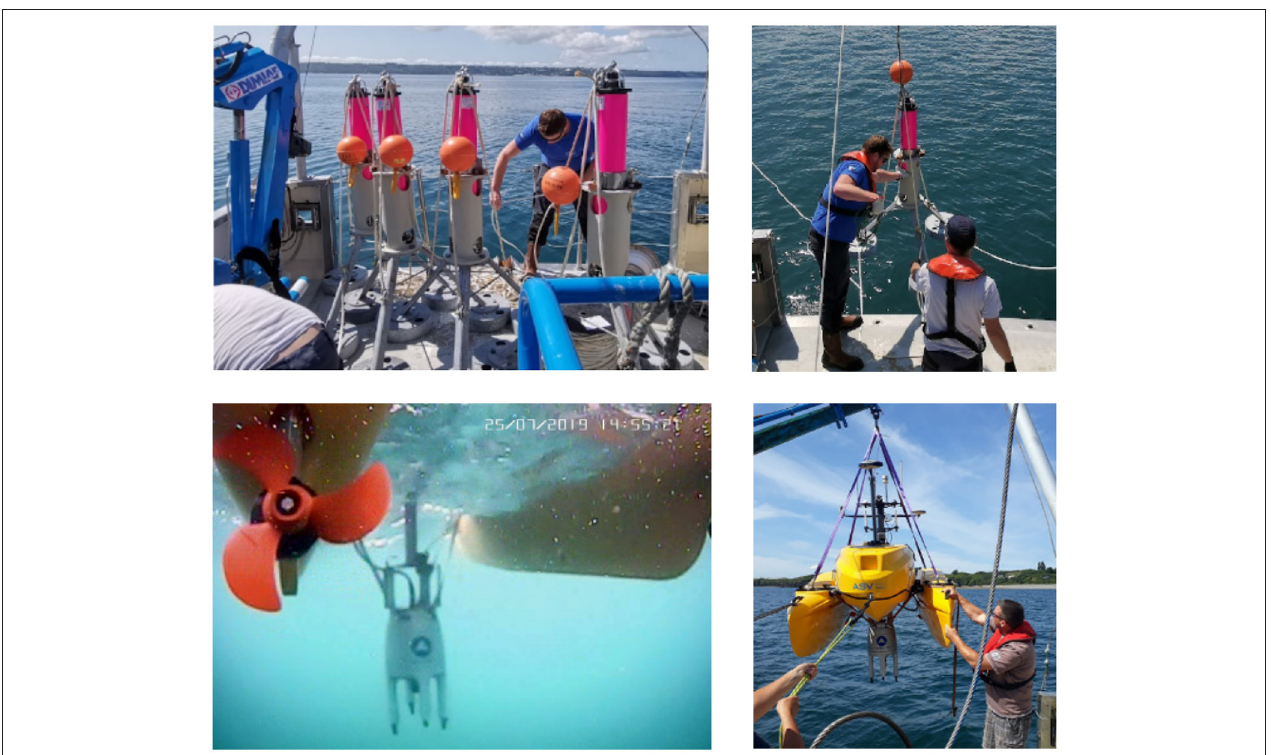
FIGURE 2 | (Upper left and upper right) Preparation and deployment of the CANOPUS transponders mounted on tripods. The fourth one was not used in this study; (Lower left) iXblue integrated USBL/INS system (GAPS) mounted on PAMELi adjustable daggerboard; (Lower right) Deployment of PAMELi USV from R/V Albert Lucas. Note the installation of the GNSS antenna on the daggerboard, directly above the